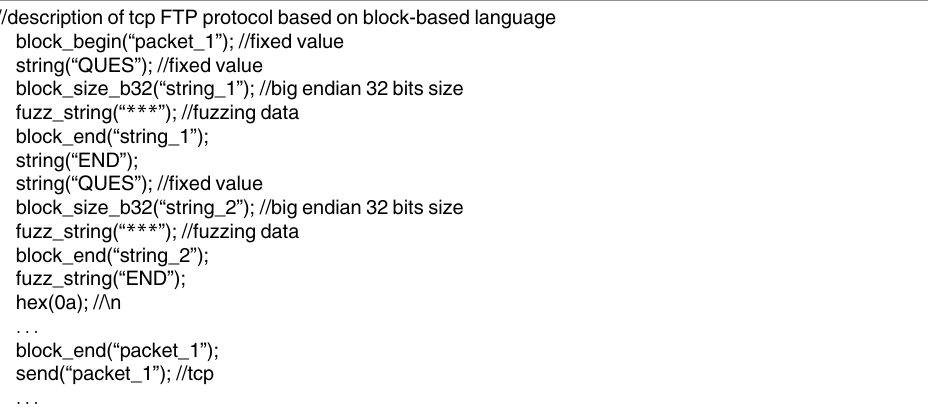
Table 3. Description of FTP protocol based on block-based